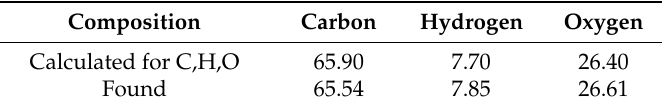
Table 1. Comparison of the experimental and calculated elemental composition of an alternating copolymer poly[(4-methyl-1-pentene)-alt-maleic anhydride] (C 10 H 14 O 3 ). Composition